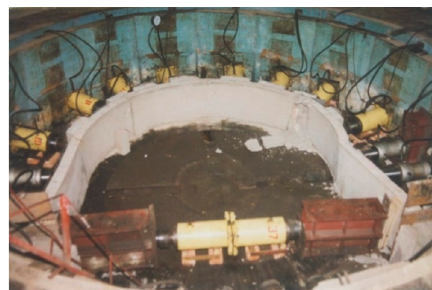
Figure 13: Failure state of the model.